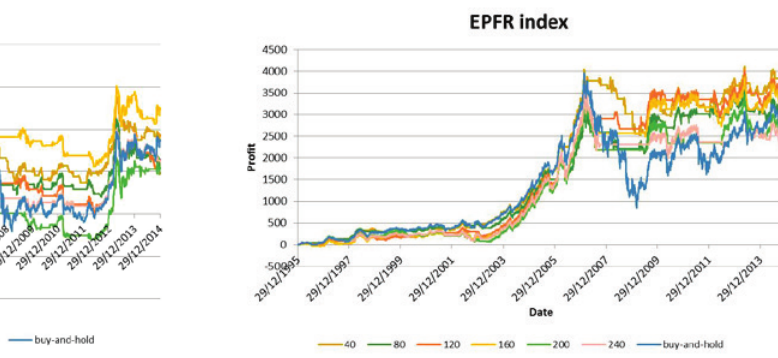
Figure 5. Profits of our strategy and “buy-and-hold” on EPFR index (without transaction costs)